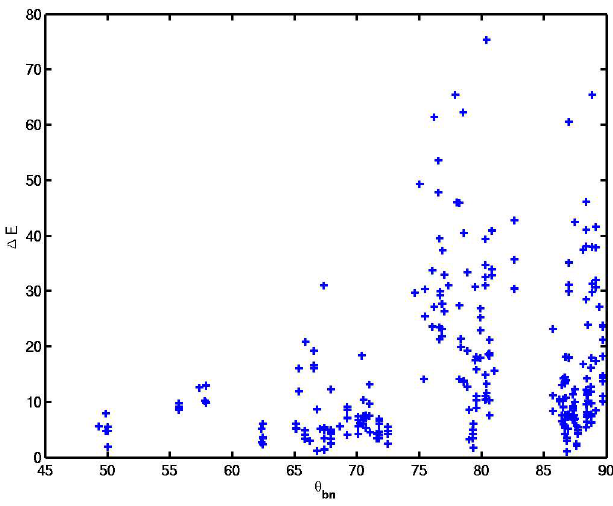
Fig. 12. The relationship between 1E and θ Bn